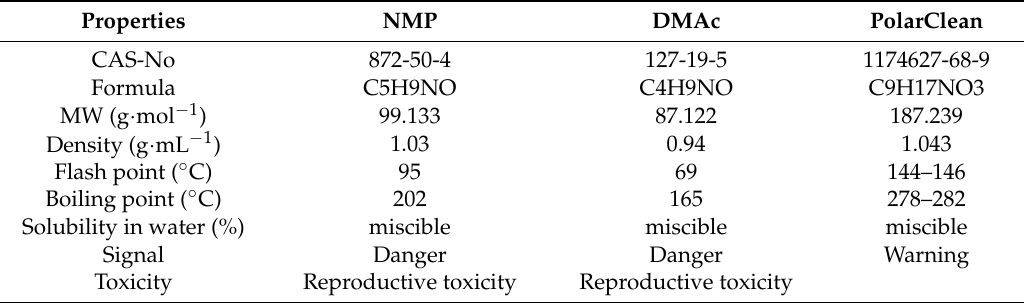
Table 1. Physicochemical properties of NMP, DMAc and